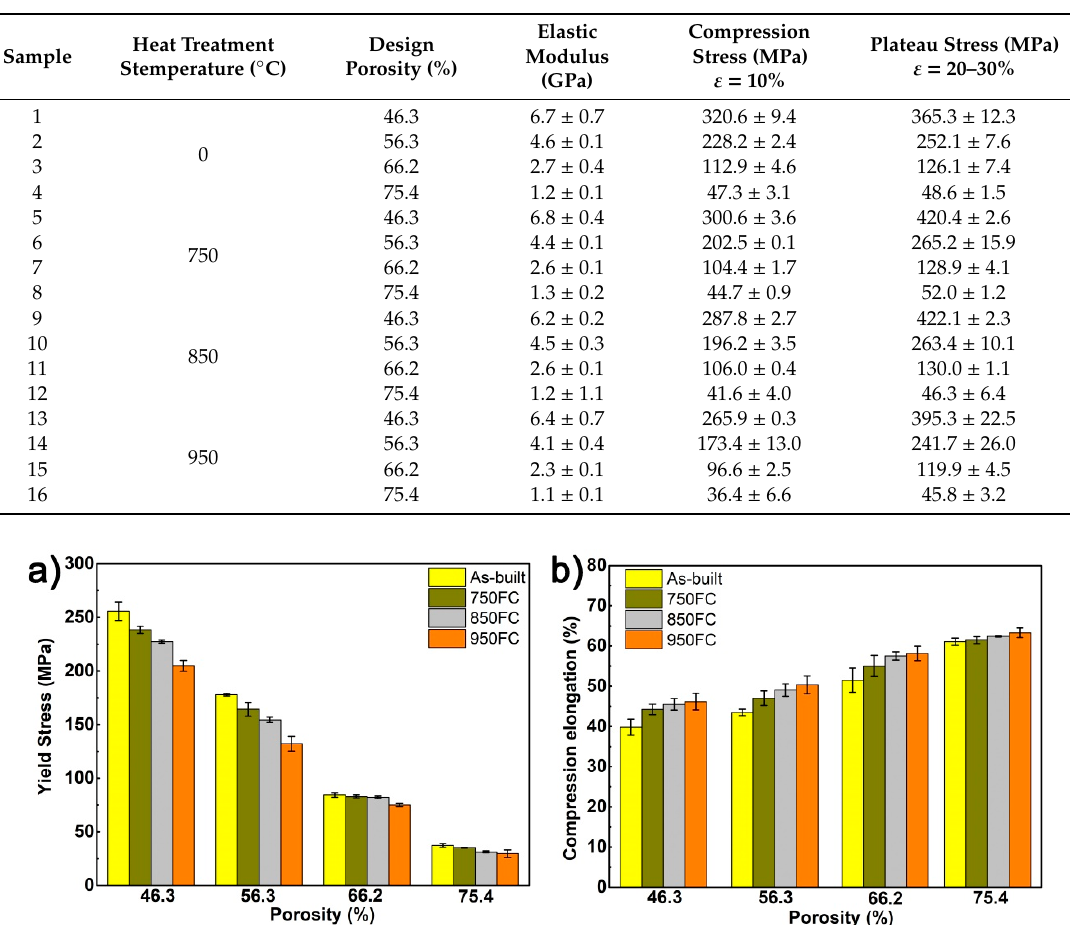
Figure 10. Compressive yield strengths ( a ) and compressive elongations ( b ) of the porous Ti64 samples under different heat treatments.